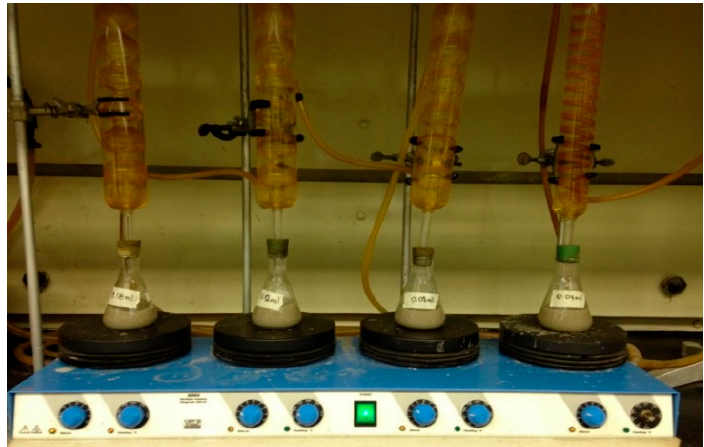
Figure 4. Hot plate magnetic stirrer for solubility evaluation.